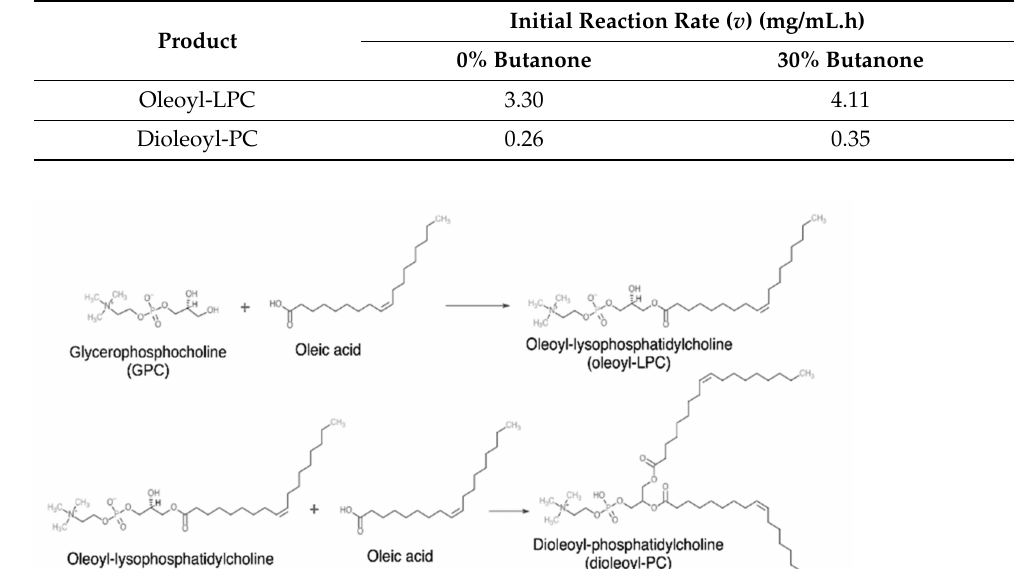
Table 2. Summary of initial reaction rate ( v ) for the GPC esterification products.